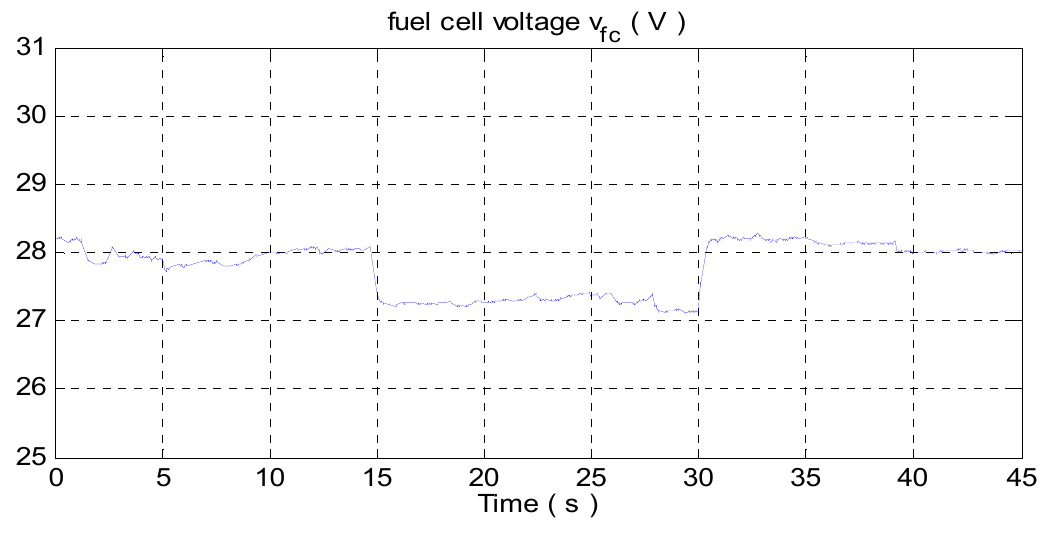
Figure 21. Fuel cell voltage v fc . Figure 22 illustrates the capacitor voltage v c